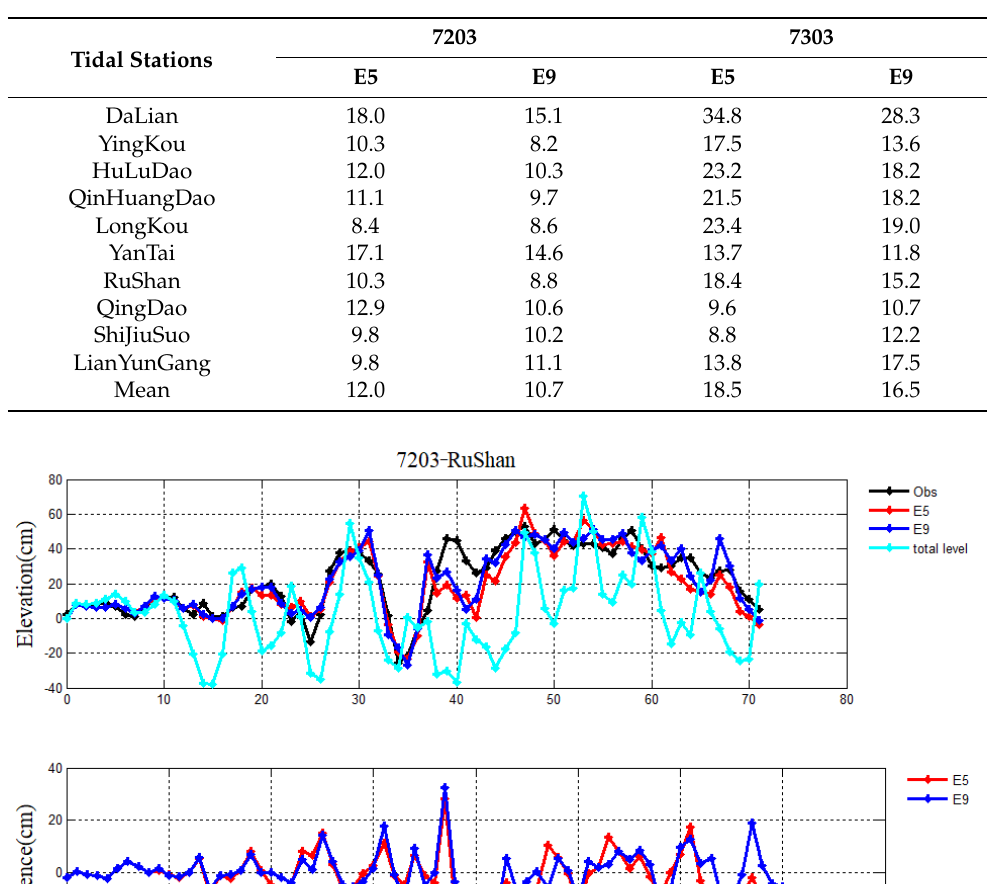
Table 10. Root–mean–square errors between simulated and observed storm surge levels at 10 tidal stations during Typhoons 7203 and 7303 (unit: cm).